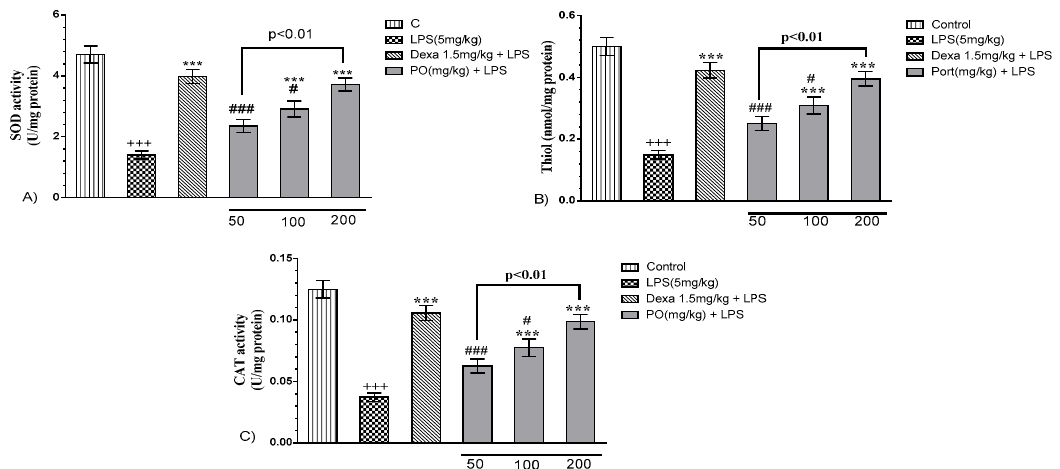
Figure 5. Effects of PO extract on anti-oxidative indices: ( A ) SOD, ( B ) thiol, and ( C ) catalase (CAT) in BALF and lung tissue. Data were presented as mean ± SEM ( n = 6). +++ p ≤ 0.001 compared with the control group, *** p ≤ 0.001 compared with the LPS-induced group, # p ≤ 0.05 and ### p ≤ 0.001 compared with the Dexa + LPS group.